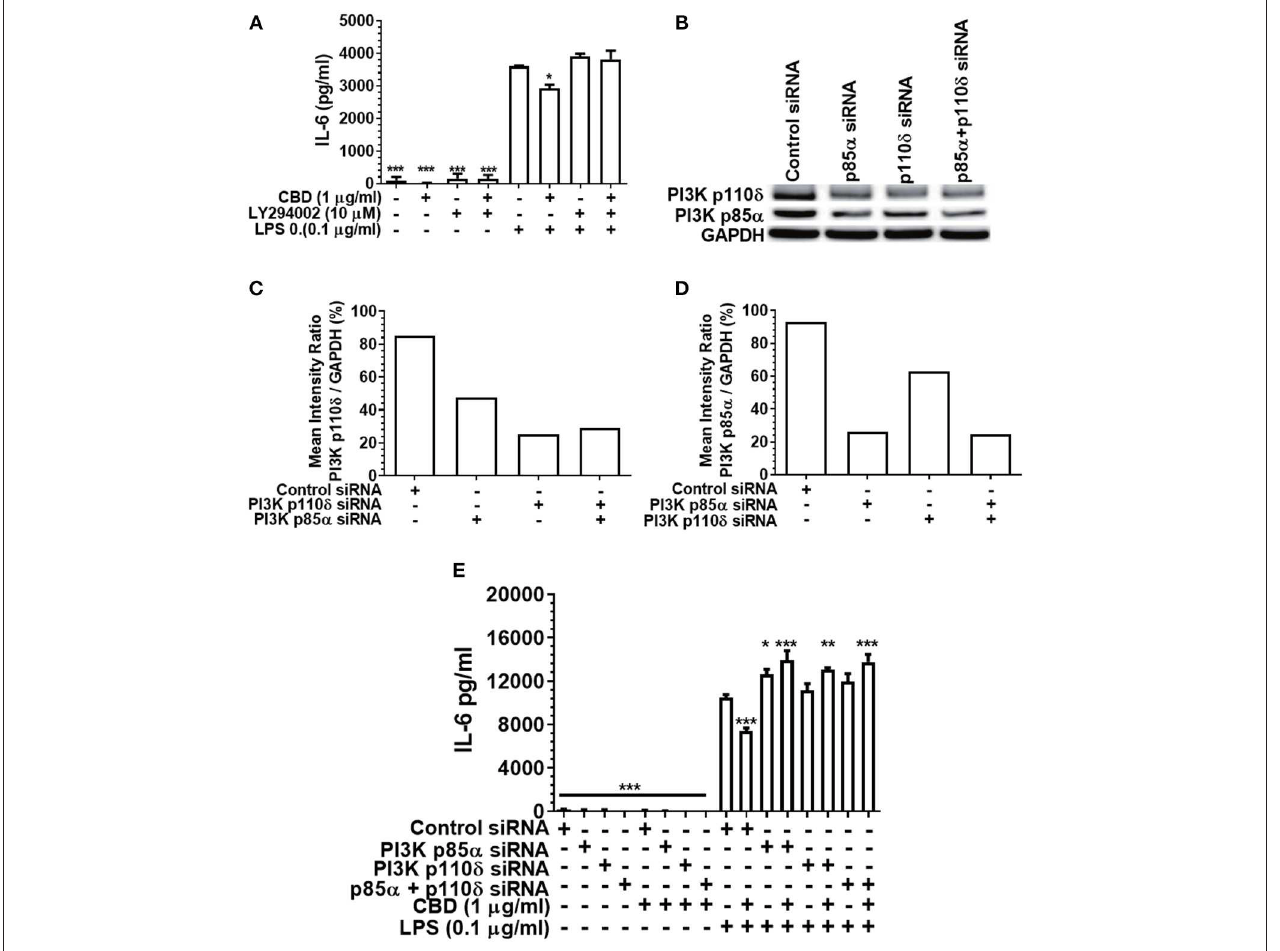
FIGURE 5 | Inhibition or silencing of PI3K abrogates CBD-mediated innate suppression. IL-6 (A,E) concentrations in 20h cell-free supernatants were collected from primary human monocytes stimulated, or not, with LPS (0.1 µ g/ml) in the presence or absence of CBD (A) with and without CB2 blockade by LY294002; or (E) with or without PI3K p110 δ and/or p85 α silencing using siRNA. Efficient PI3K knockdown was confirmed using Image J software (B–D) . Similar data were obtained for IL-8 ( data not shown ). (A,E) Data represent the mean ± SD of three biological replicates. (B–D) Representative data are presented. * / ** / *** p ≤ 0.05/0.01/0.001, compared to (A) LPS-stimulated control or (E) control siRNA, LPS-stimulated